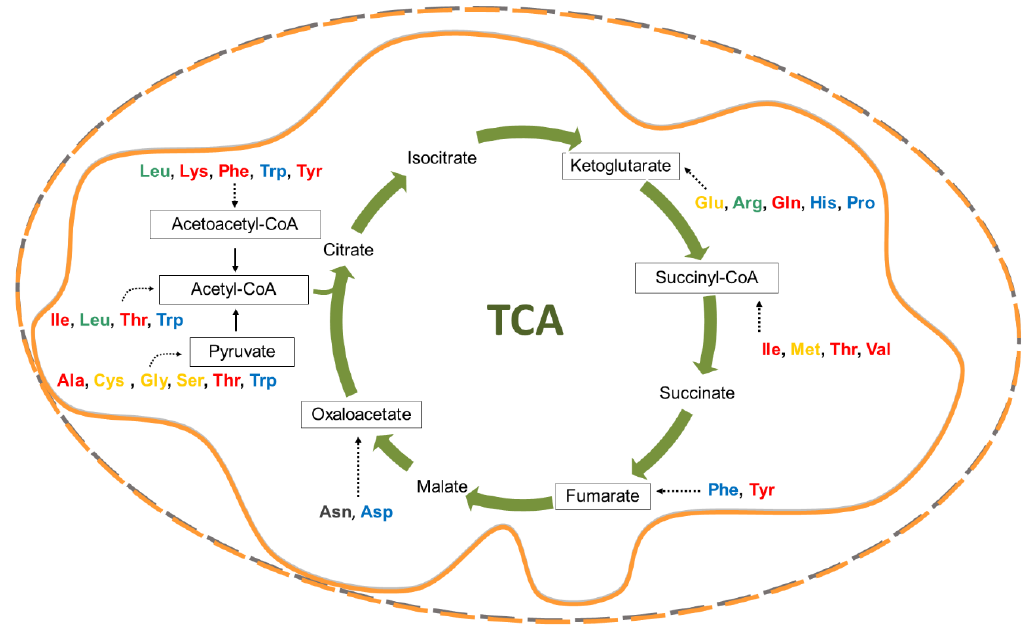
Figure 1. Schematic representation of amino acid catabolic processes. The Tricarboxylic acid cycles reactions are represented by green arrows conducting to the respective intermediate products. The boxed intermediates, including the non-TCA intermediate Acetoacetyl-CoA, are the sites of amino acid confluences for carbon skeleton oxidation. In red, amino acids mainly involved in energy production; in yellow, amino acids mainly involved in redox balance; in blue, amino acids mainly involved in cell invasion and metastasis; in grey, amino acids mainly involved in apoptosis; in green, amino acids mainly involved in mTOR activation. The continuous or dotted black arrows represent non-TCA reactions or pathways, respectively.